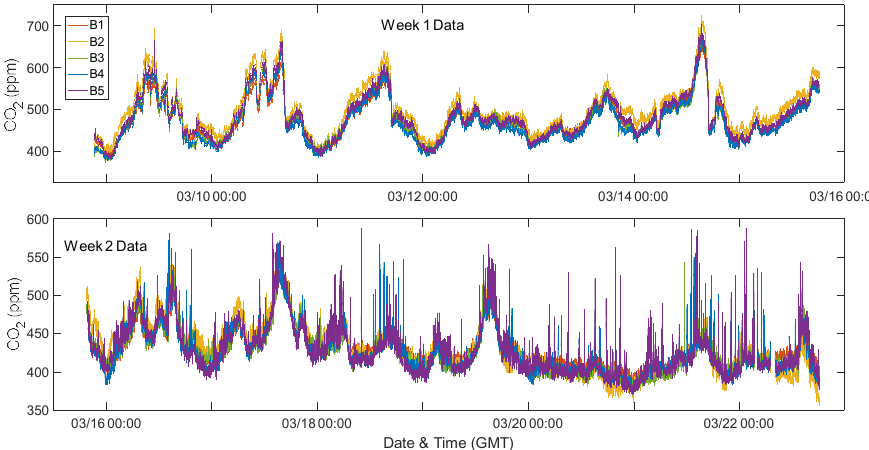
Figure A3. Time series of co-located ( top ) and deployed ( bottom ) Y-Pods, for examining neighborhood-scale variability of O 3 .